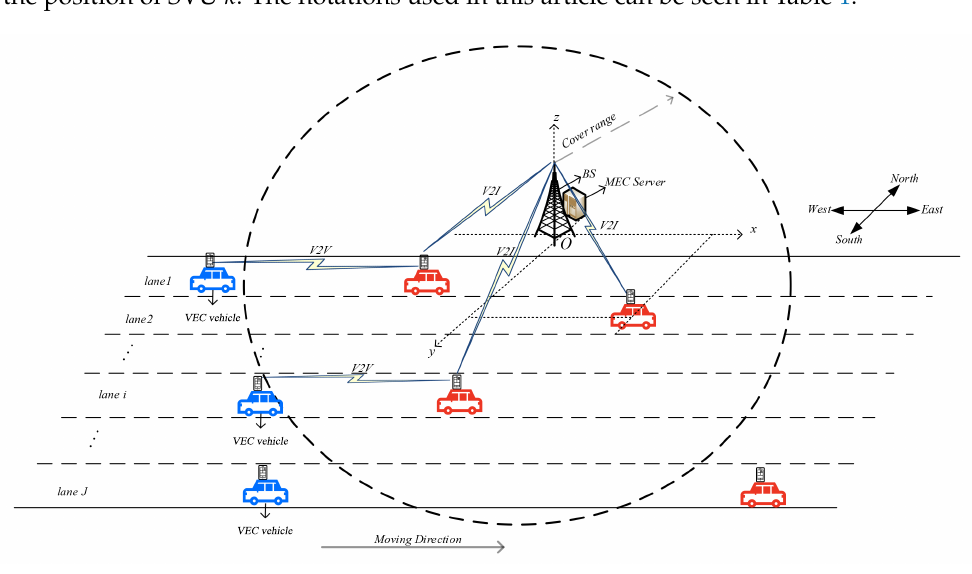
Figure 1. System